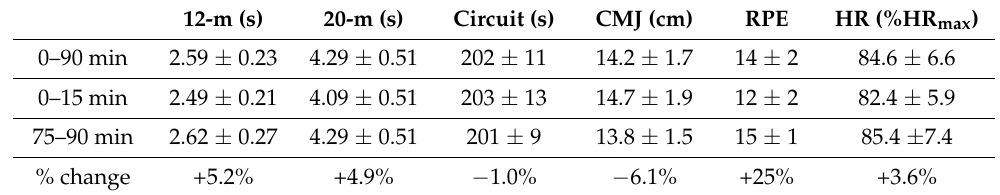
Table 1. Sprint (12-m and 20-m) times, countermovement jump (CMJ) height, circuit time, ratings of perceived exertion (RPE) and heart rate (HR) averaged different time intervals during the simulated football exercise (BEAST 90 ).